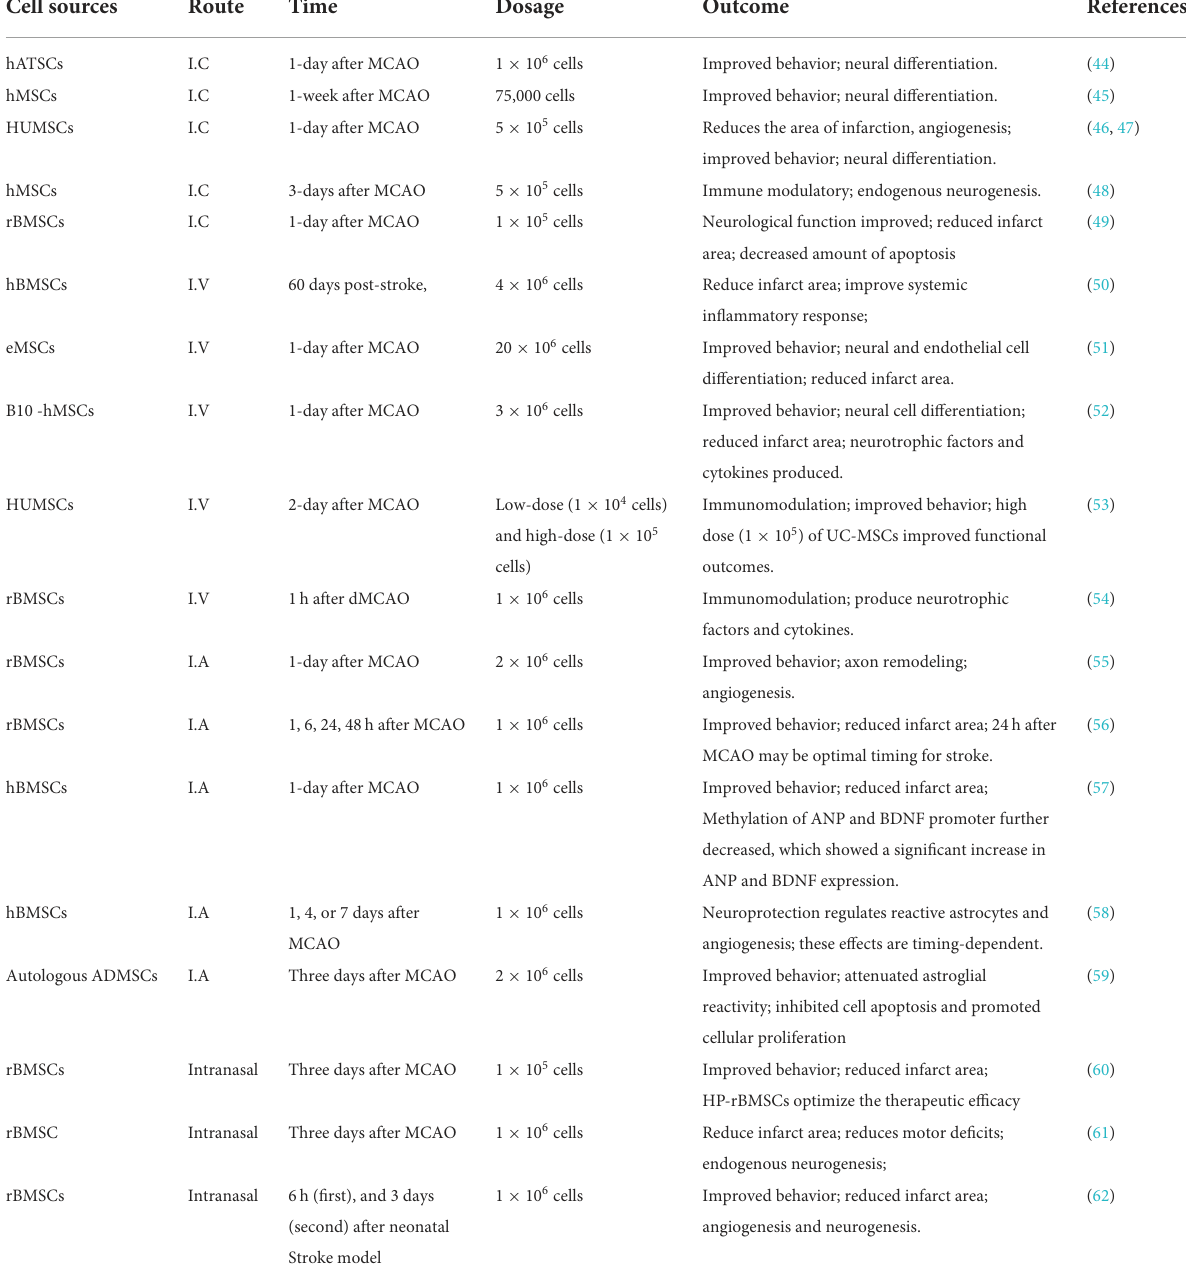
TABLE 2 Preclinical studies of MSCs for the treatment of ischemic